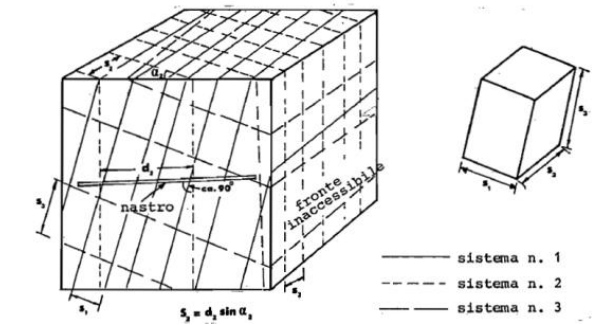
Figure 2. Measurement of joint spacing from observation of a rock